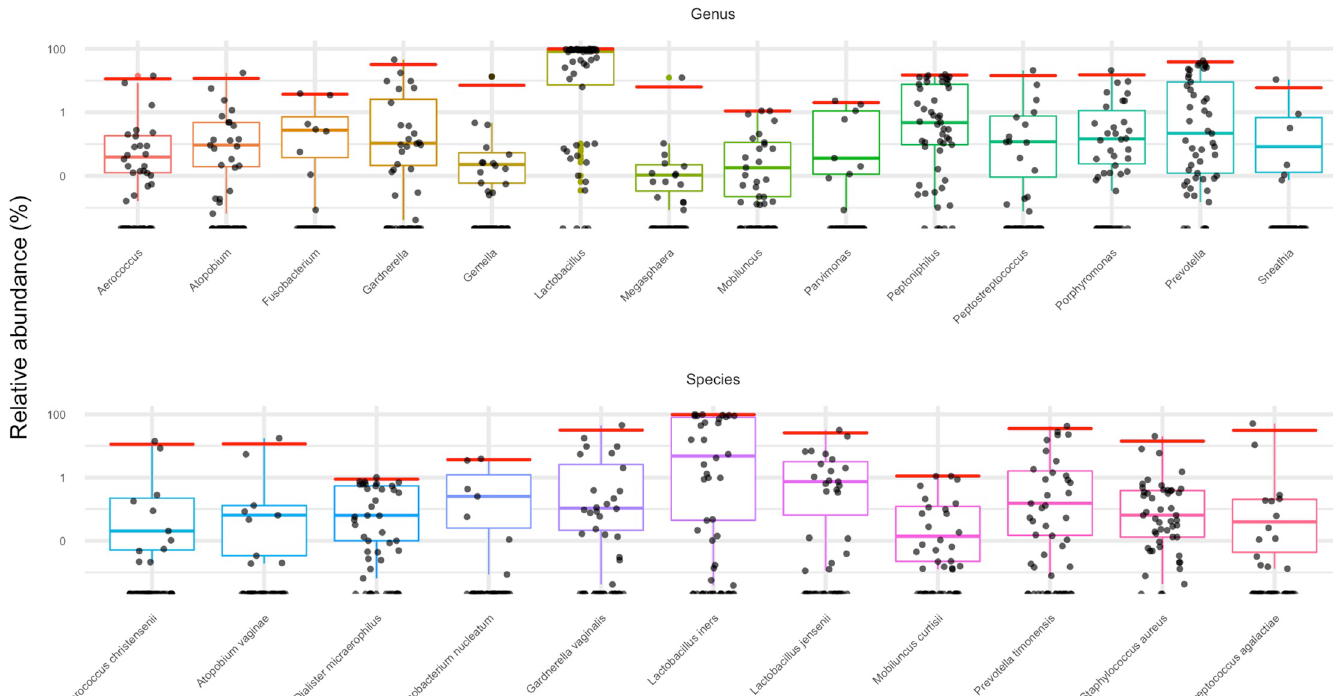
Fig 4. Reference ranges for the bacterial targets in the assay. A set of 50 vaginal samples, each from a different woman, was selected based on the self-reported answers given to survey questions indicating general and vaginal health. Each dot represents the relative abundance of a different bacterial target on genus level (top) or species level (bottom) within a different vaginal sample. Boxes indicate the 25th-76th percentile, with the median indicated inside each colored box. Red lines indicate the 99% percentile of each distribution, and are also the cutoff for the reference ranges. Not all of the taxa used in the assay were plotted, as some had no abundance values for this healthy cohort ( Papillibacter , C . trachomatis , M . mulieris , M . genitalium , N . gonorrhoeae , P . amnii ), based on the exclusion criteria.